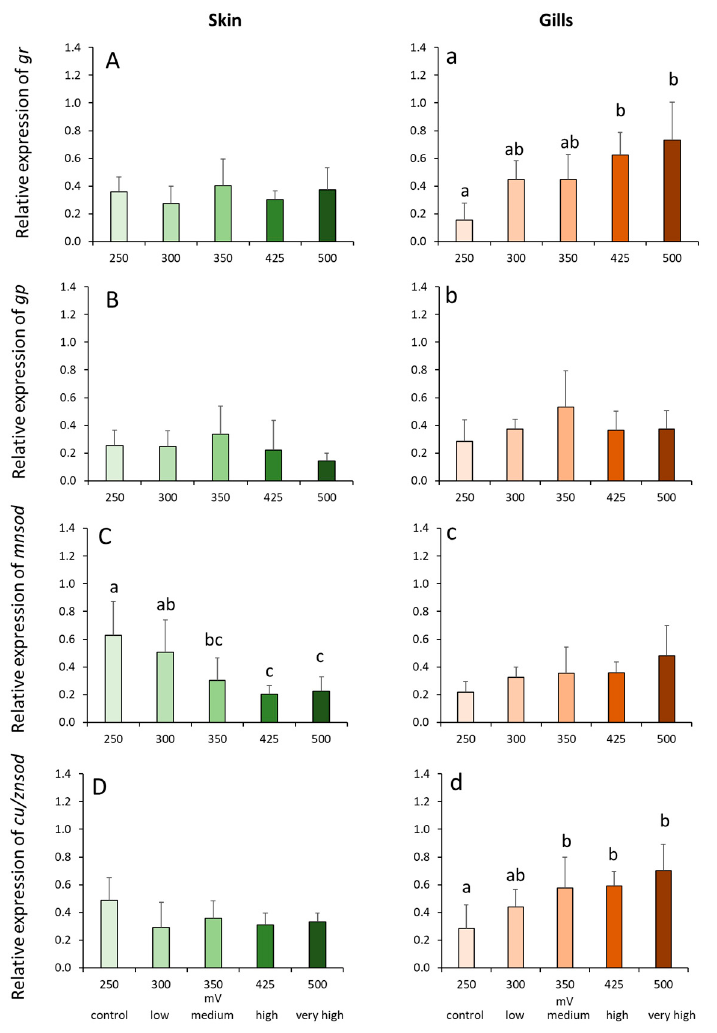
Figure 3. Relative expression of antioxidant defense genes in the skin ( A – D ) and gills ( a – d ) of Atlantic salmon exposed to varying ORP levels. Values are presented as mean and standard deviation of 6 individual fish per treatment group. Di ff erent letters denote significant di ff erence between treatments at p < 0.05.